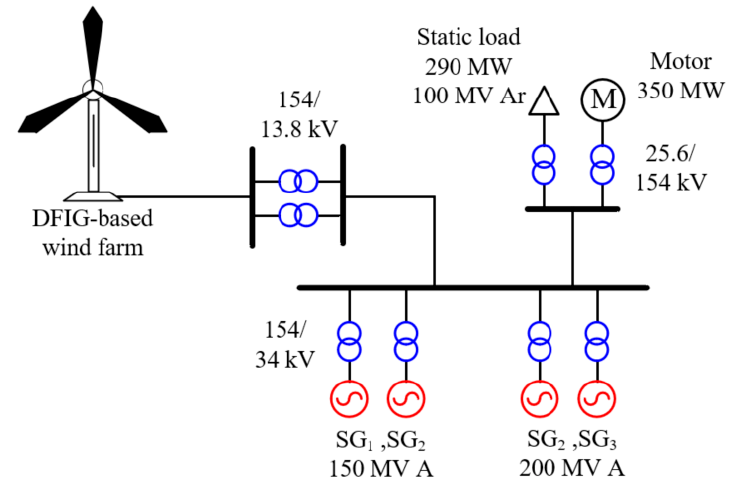
Figure 8. Model system.